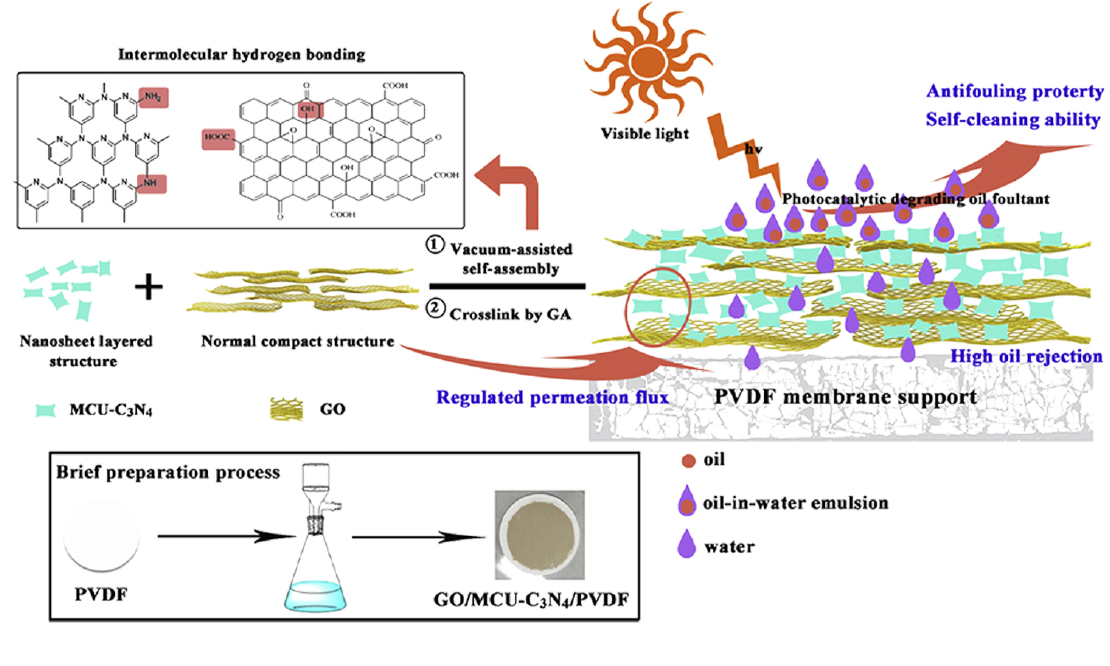
Figure 11. The fabrication process of photocatalytic gCN(H) membranes. Reprinted from [224], Copyright (2019), with permission from